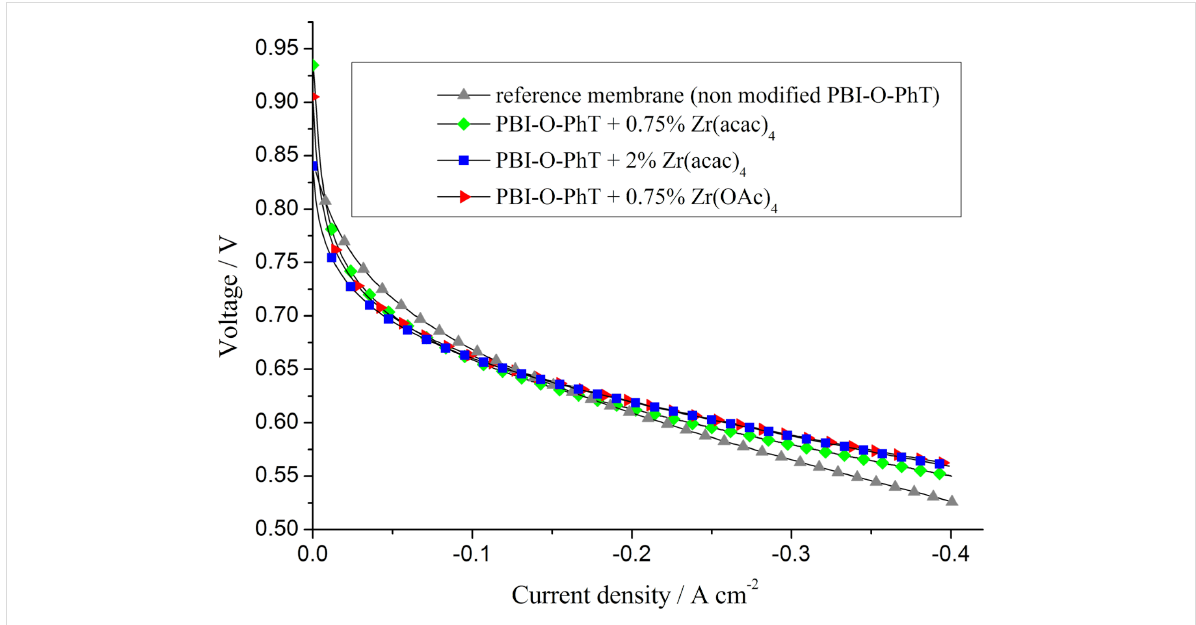
Figure 8: Performance of fuel cells based on PBI membranes of different types. Air is used as an oxidant, T = 160 °C.